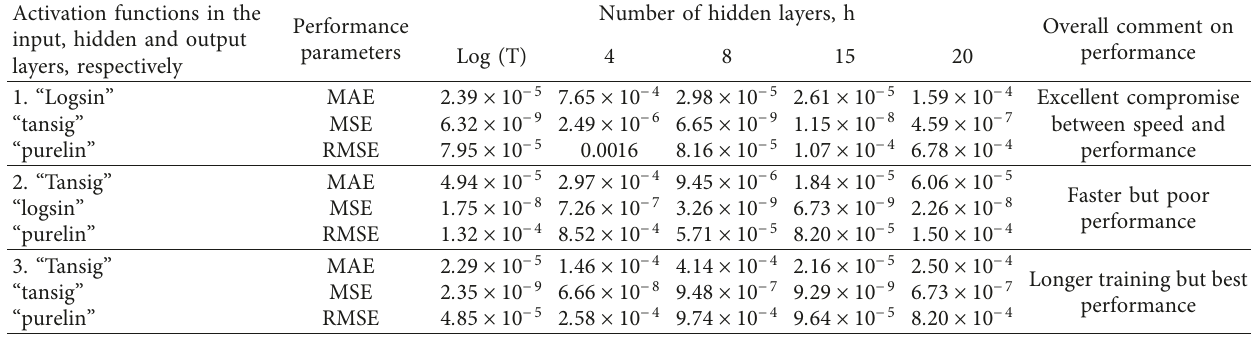
Table 4: BPNN training performance results.